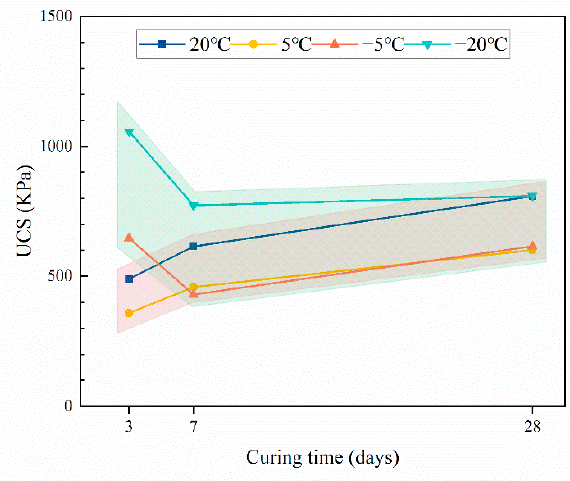
Figure 4. Evolution characteristics of CTB strength with curing time (CTR is 1:12).